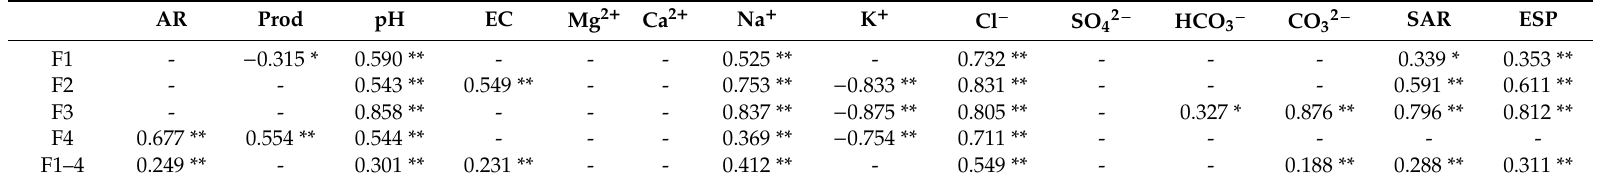
Table 10. Pearson’s correlation coe ffi cient among C / N ratio, application rate, corn production, and soil chemical